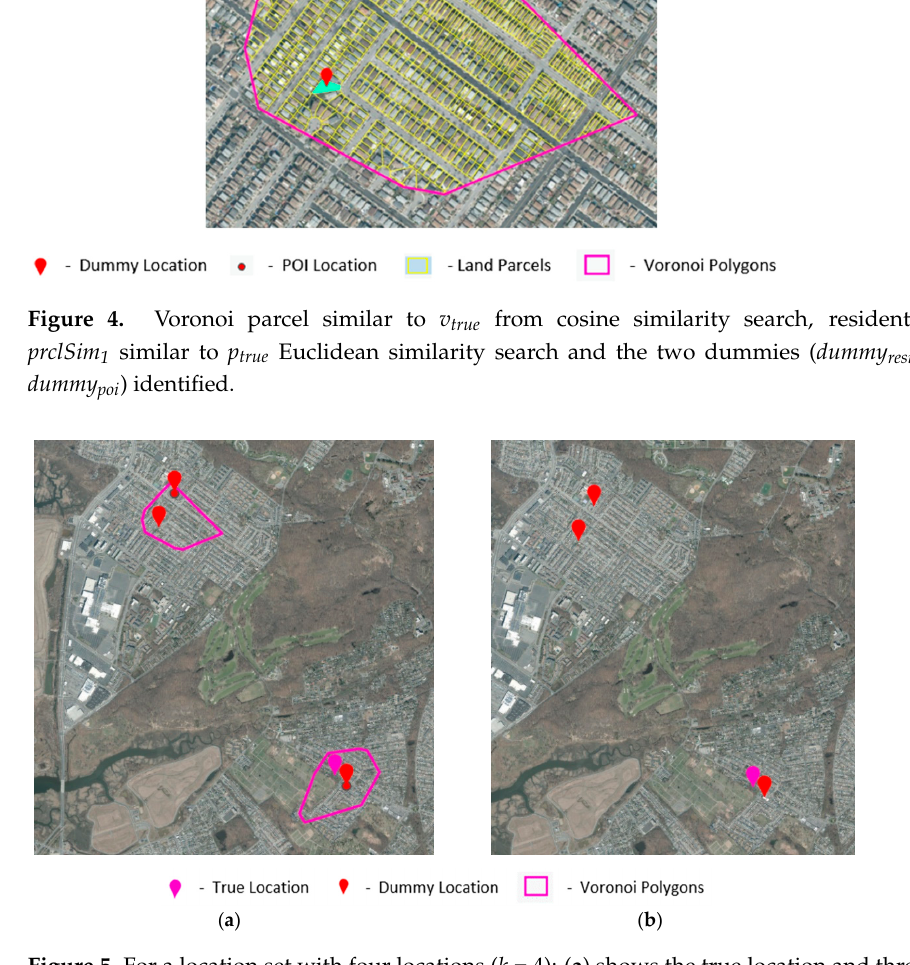
Figure 5. For a location set with four locations ( k = 4): ( a ) shows the true location and three dummy locations with their respective Voronoi polygons and ( b ) shows the true and dummy locations only.